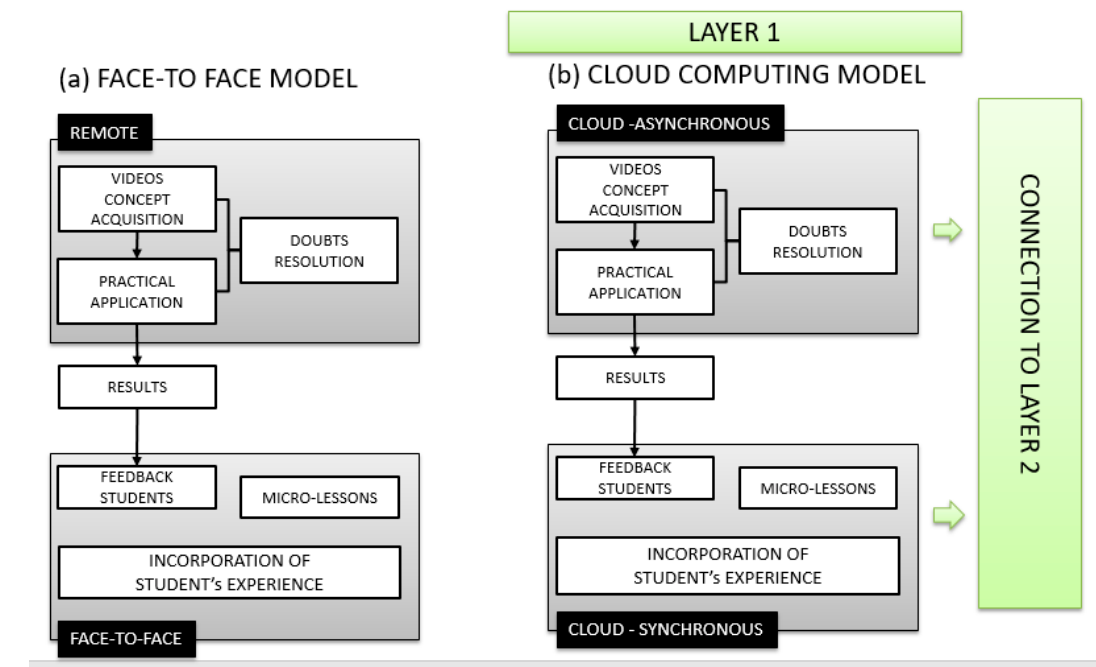
Figure 1. Functional model of Layer 1.